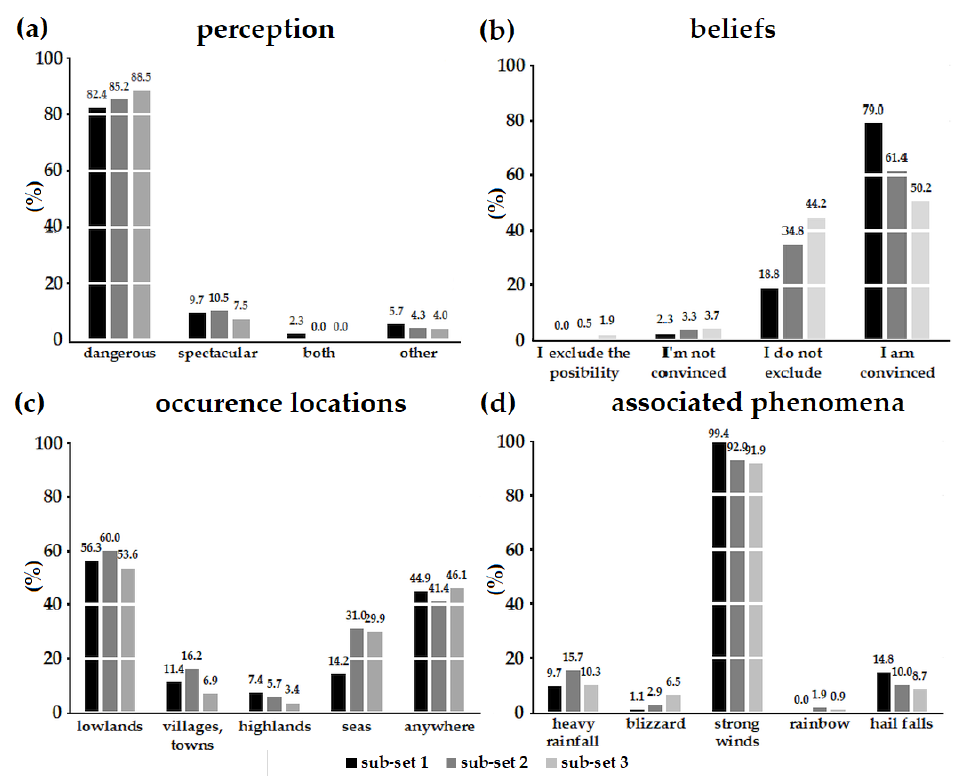
Figure 6. The distribution of results in sub-sets for questions Q2 to Q5 regarding: the respondents’ perceptions ( a ), their beliefs ( b ), their knowledge on occurrence locations ( c ) and the most dangerous associated phenomena ( d ).